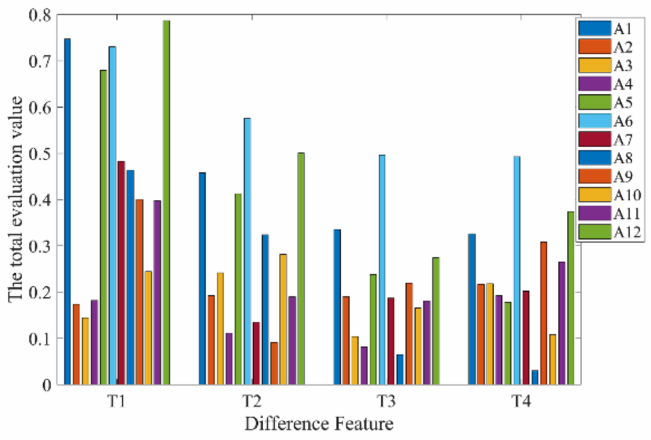
Figure 6. Histogram of the total evaluation values of difference features to algorithms.